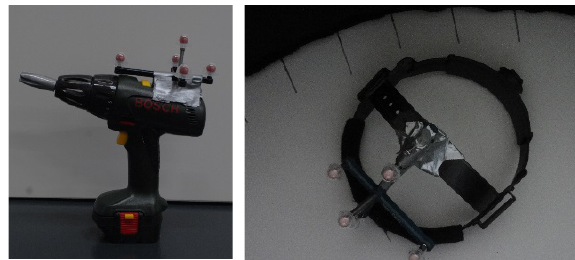
Figure 2. Left: Toy drill with probe, Right: Head mount with probe